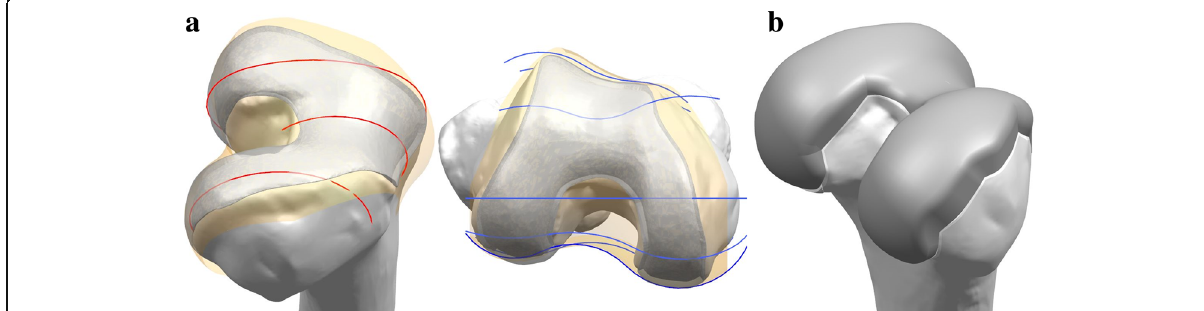
Fig. 1 The method of development for patient-specific femoral component: a patient-specific curves from sagittal and coronal planes used in the design; b developed patient-specific femoral